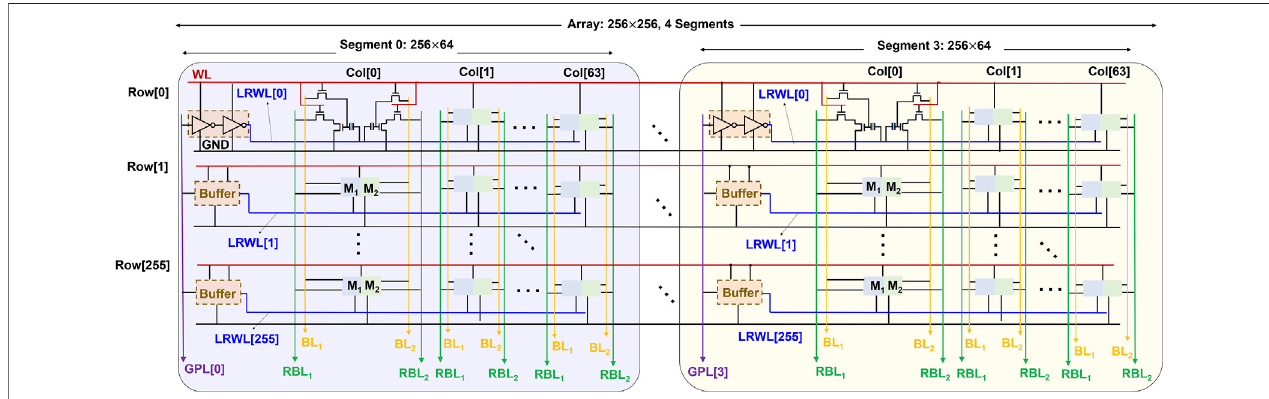
FIGURE 8 | Segmented array of STeP-CiM of size 256 × 256, comprising 4 segments, each of size 64 × 256.